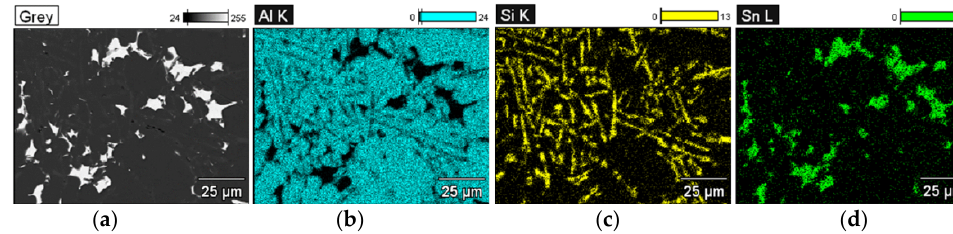
Figure 12. SEM-EDS analysis of microstructure and chemical composition of Si10Sn1.7 alloy: ( a ) image of microstructure with analysis points; ( b ) plot of spectra in Area 1; ( c ) plot of spectra in Area 2.